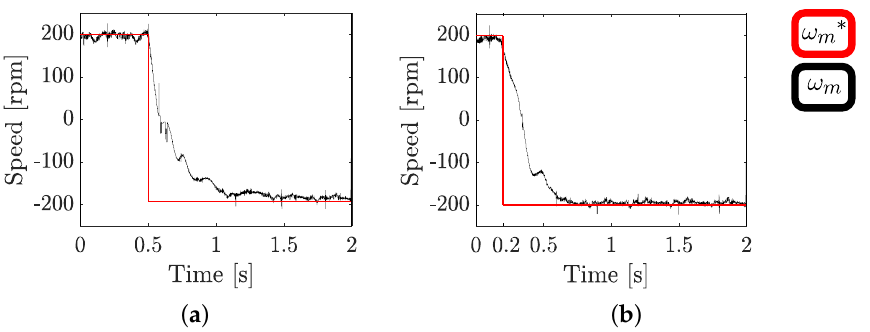
Figure 10. Reversal condition from 200 (rpm) to − 200 (rpm) at 2.5 (kHz) of sampling frequency: